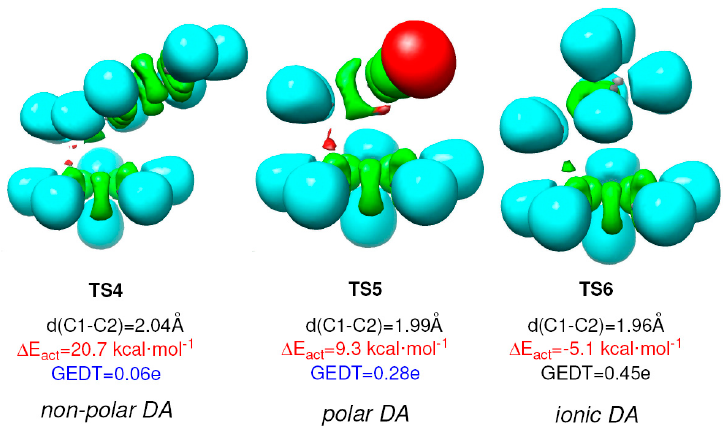
Figure 6. B3LYP/6-31G(d) ELF valence basins, C–C distances, activation energies and GEDT of the TSs involved in the non-polar, polar and ionic DA reactions of Cp 6 with styrene 10 , TS4 , dicyanoethylene 11 , TS5 , and iminium cation 12 , TS6 .